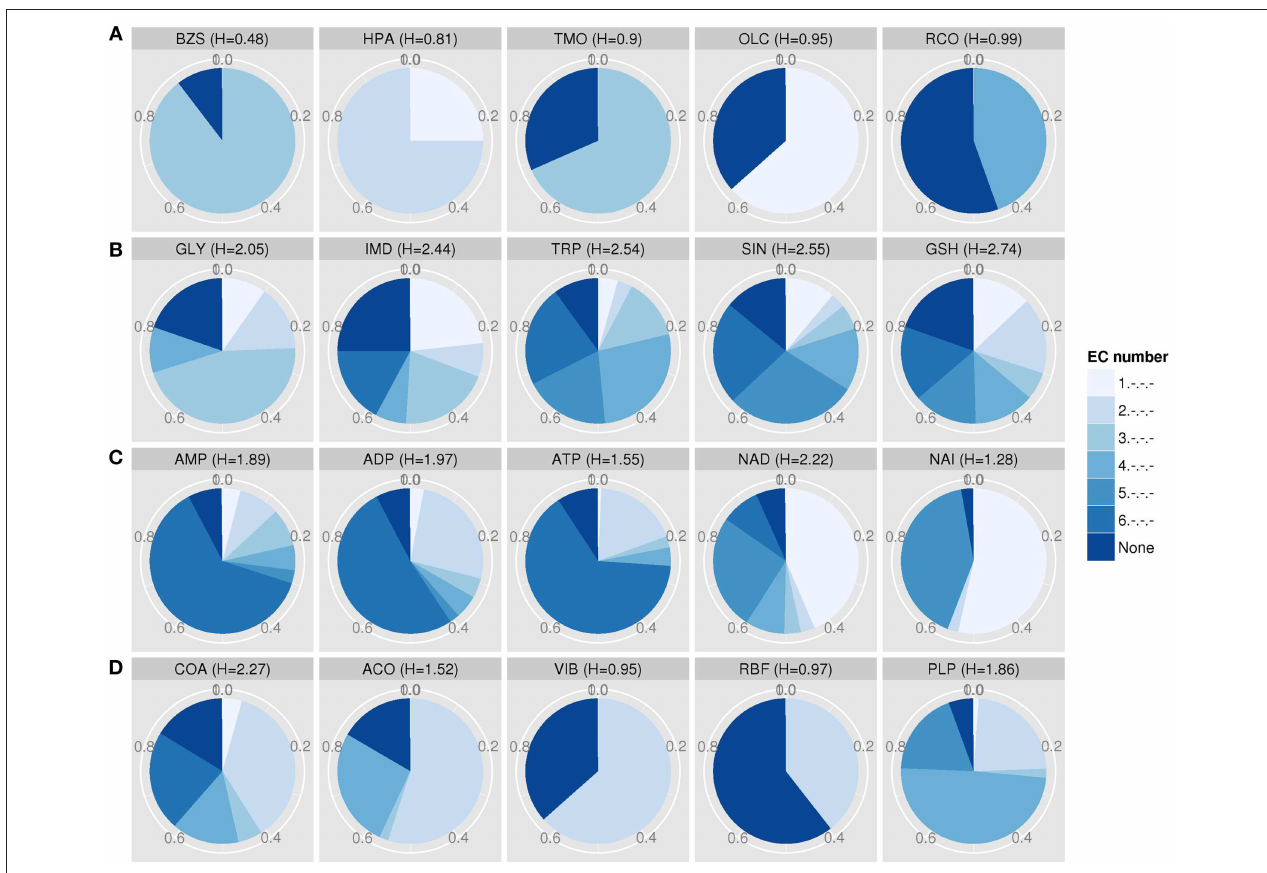
FIGURE 5 | EC entropies of metabolites with at least five target proteins. (A) The top five metabolites with the lowest EC entropy: benzylsuccinate (PDB ID: BZS), hypoxanthine (HPA), trimethylamine N-oxide (TMO), oleoylglycerol (OLC), and resorcinol (RCO). (B) The bottom five metabolites with highest entropy: Glycine (GLY), imidazole (IMD), tryptophan (TRP), succinate (SIN), and glutathione (GSH). (C) The general energy currency metabolites adenosine mono-, di- and triphosphate (AMP, ADP, ATP) and redox equivalents NAD (NAD) and NADH (NAI). (D) The cofactors and vitamins coenzyme A (COA), acetyl- coenzyme A (ACO), thiamine (VIB, vitamin B1), riboflavin (RBF, vitamin B2), and pyridoxal-5 ′ -phosphate (PLP, vitamin B6